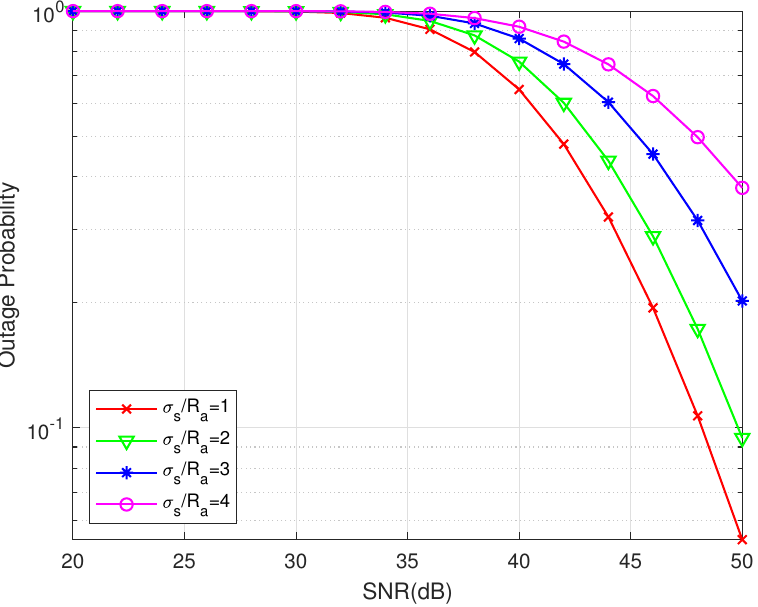
Figure 3. Outage probability of MIMO mixed RF/FSO system with different pointing